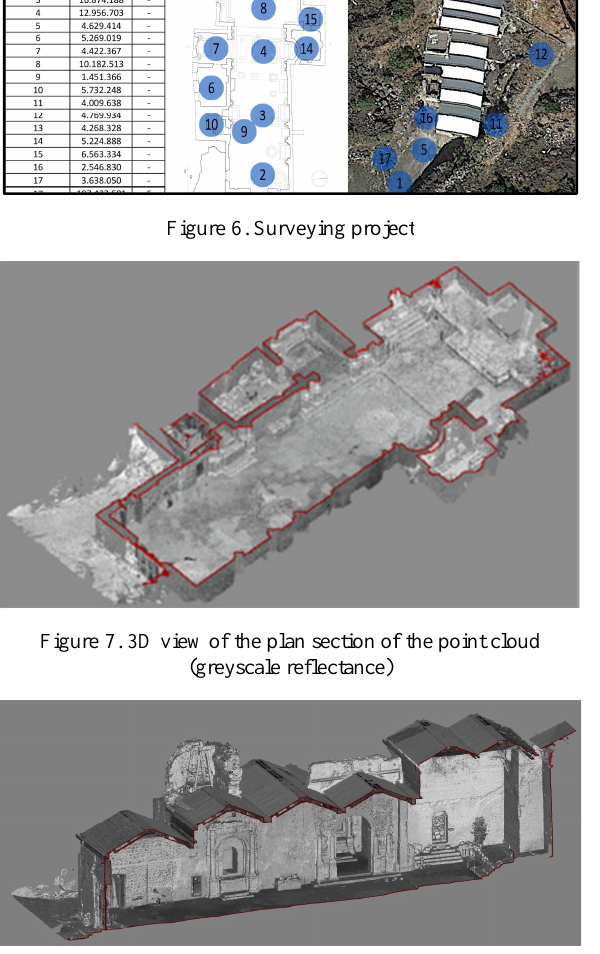
Figure 8. 3D cross section view of the point cloud (greyscale reflectance)